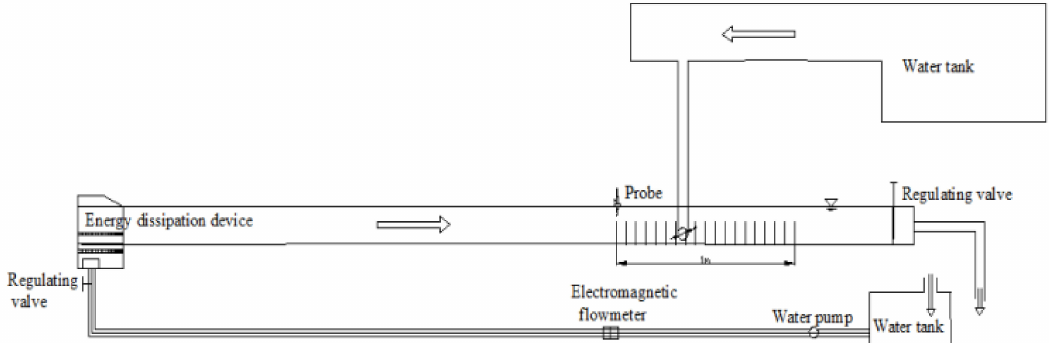
Figure 1. Sketch of the experimental